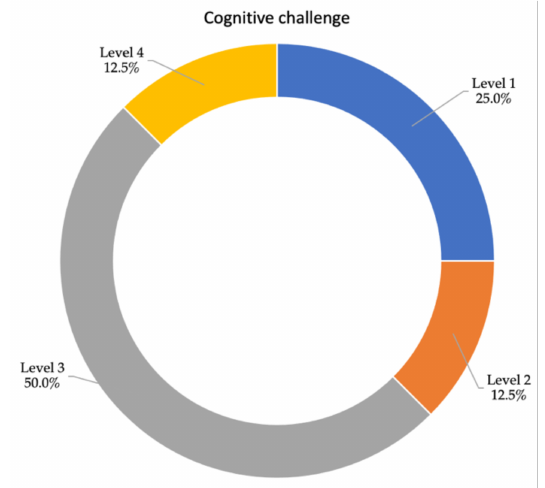
Figure 7. Cognitive challenge by